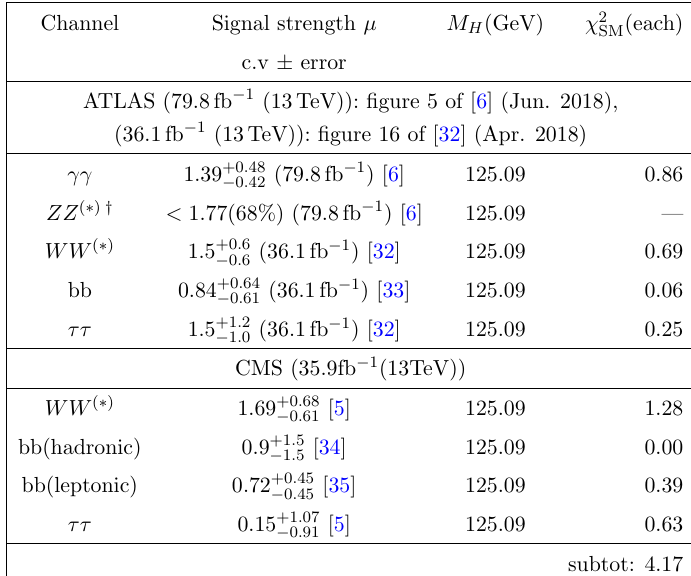
Table 14 . (LHC: 13 TeV) The same as table 9 but for exclusive ttH production mode. Open